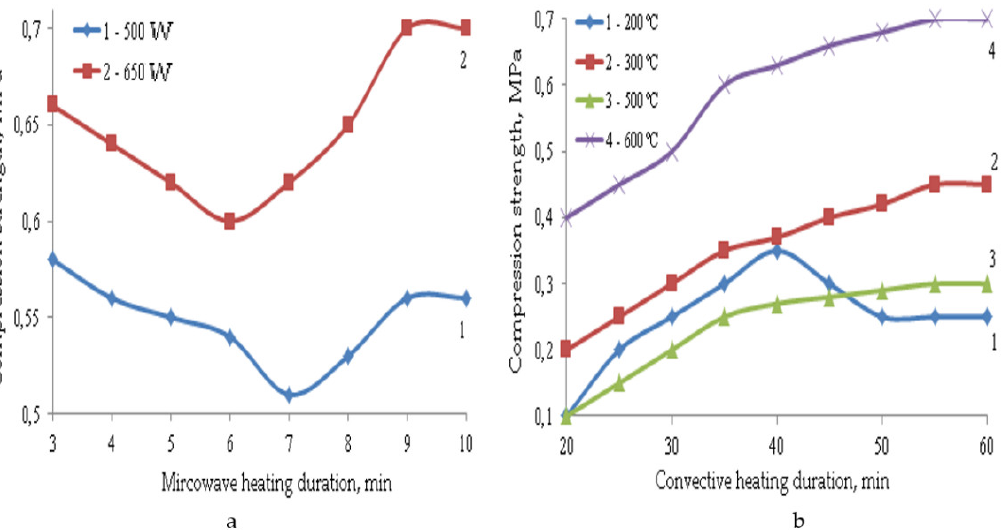
Figure 5. Dependence of the average density on the parameters of microwave ( a ) and convective ( b ) heating.